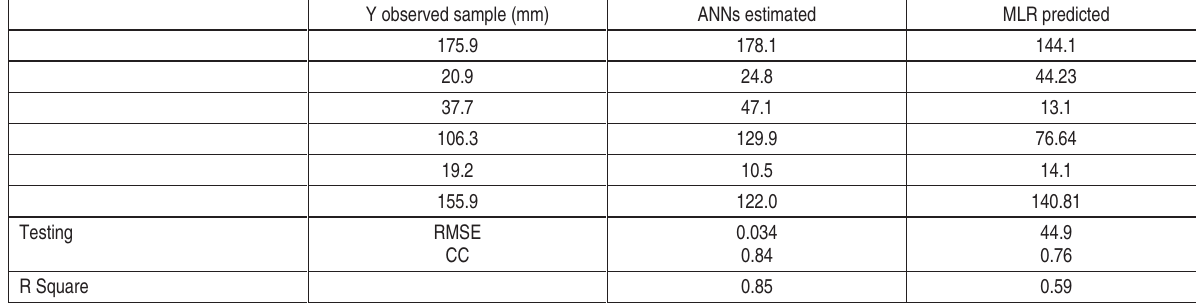
Table 2. Estimated comparison of both models which predicted rainfall case